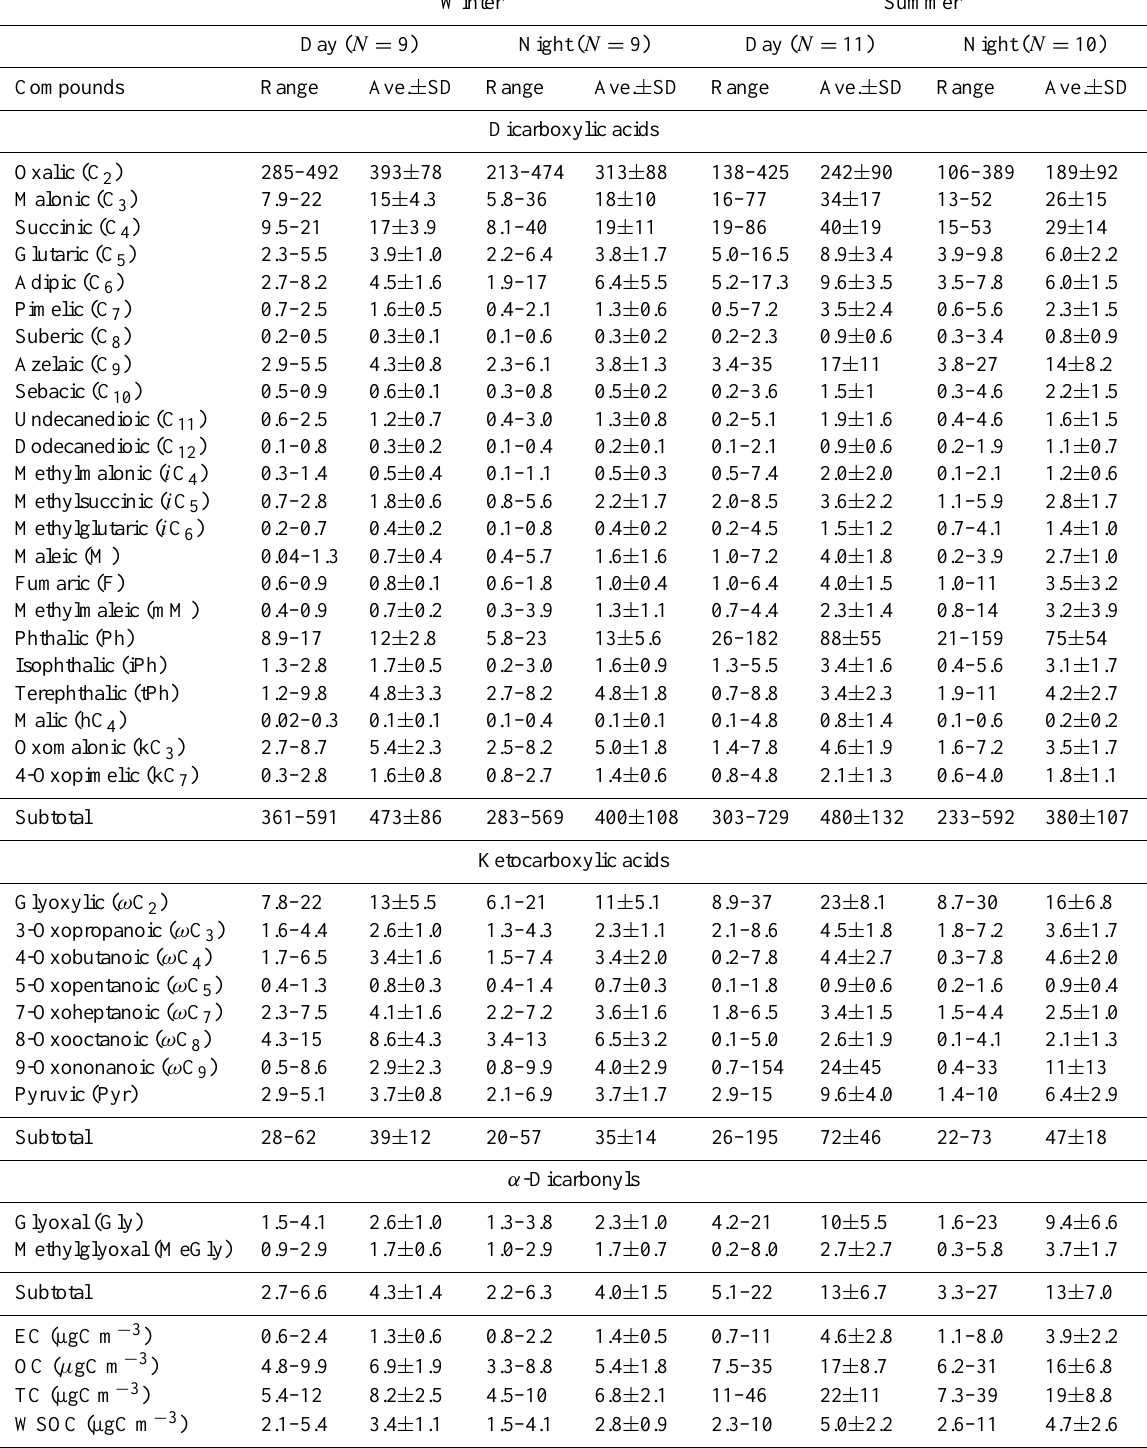
Table 1. Concentrations (ngm − 3 ) of dicarboxylic acids, ketocarboxylic acids, and α -dicarbonyls and concentrations (µgm − 3 ) of elemental carbon (EC), organic carbon (OC), total carbon (TC) and water soluble organic carbon (WSOC) in Himalayan aerosols over Nainital,